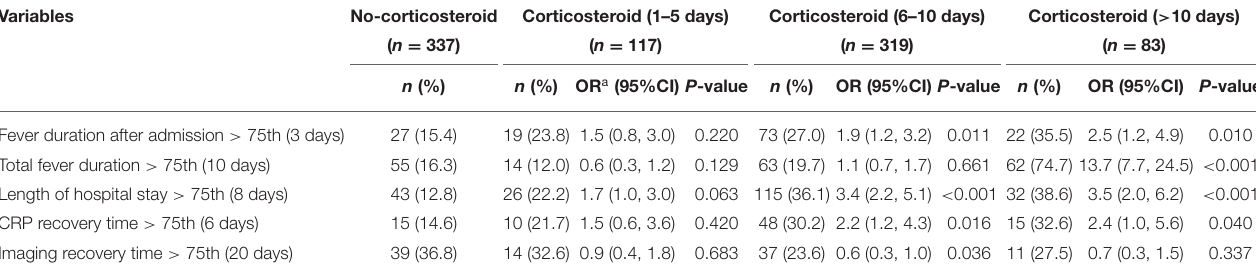
TABLE 3 | Logistic regression analysis for the effects of adjunctive corticosteroid treatment stratified by medication time in Mycoplasma pneumoniae pneumonia